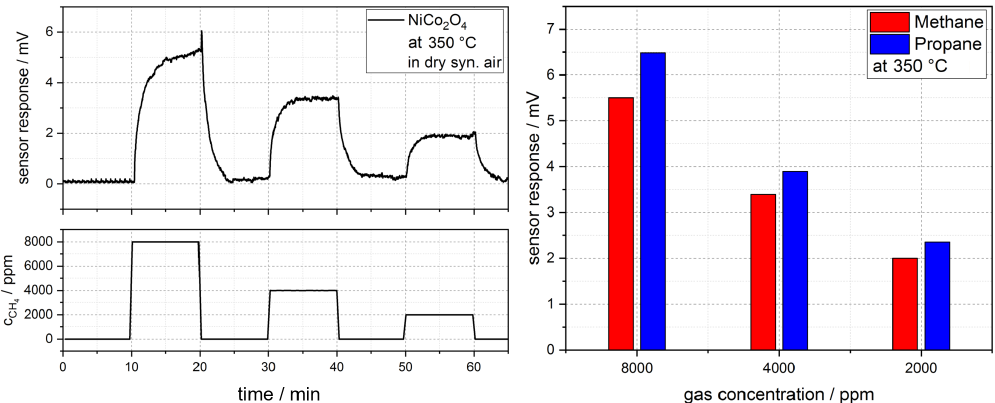
Figure 3. (a) Response of the gas sensor to different methane concentrations below the LEL in dry synthetic air at an ambient temperature of 25 ◦ C. Even 2000ppm methane ( < 5% LEL) could be clearly identified. The graph shows the sensor response without amplification. (b) Comparison of the sensor response to methane and propane in dry synthetic air. Under the same conditions the sensor shows an about 18% higher response to propane.